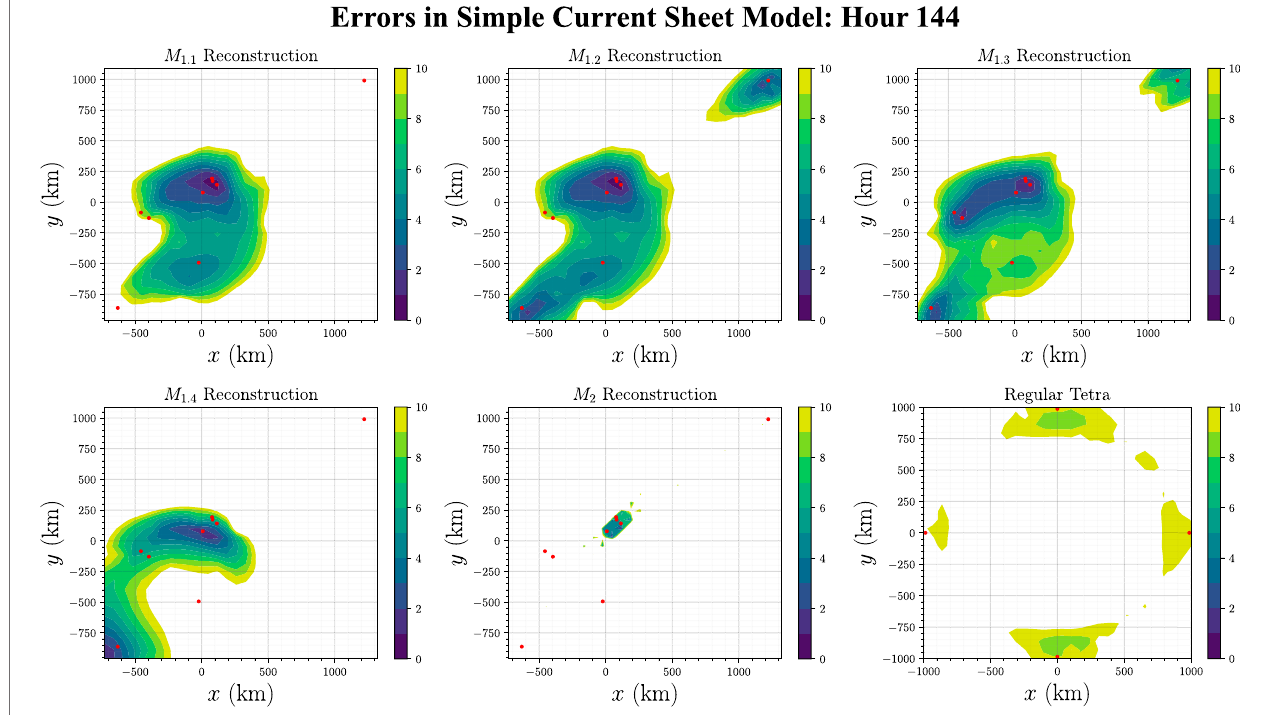
FIGURE5 | Computation error(de fi ned in Eq. 7 ) at all points on the z (cid:1) 0plane ofthe simple current sheet model, using theswarm con fi guration at hour144 ofthe HelioSwarm DRM. The layout is identical to Figure 4 .